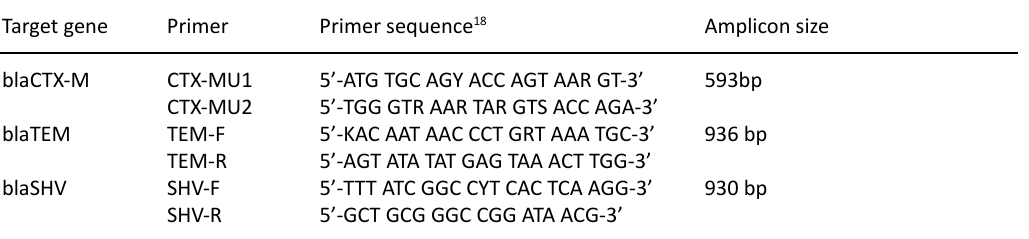
table 1. ESBL genes (CTX-M, TEM and SHV) Primers Target